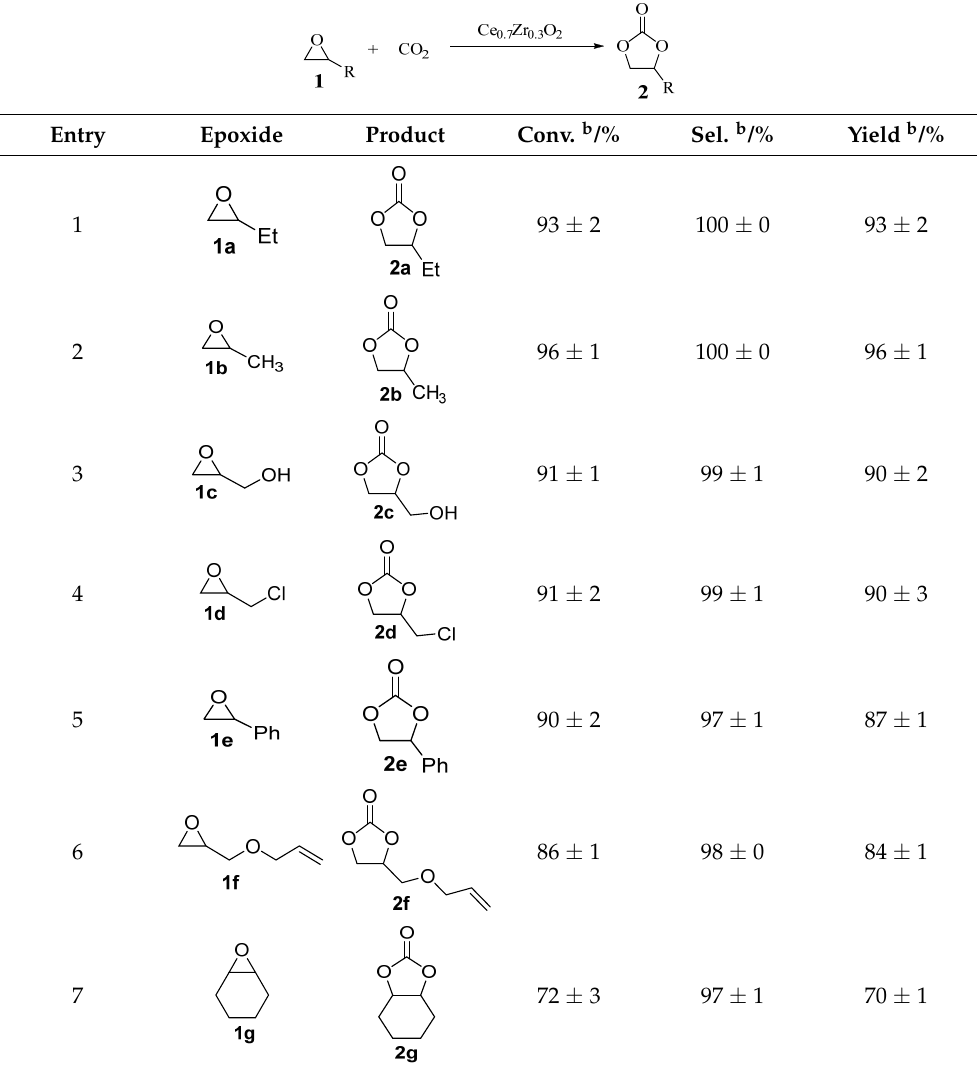
Table 5. Ce 0.7 Zr 0.3 O 2 catalyzed synthesis of various cyclic carbonates a .